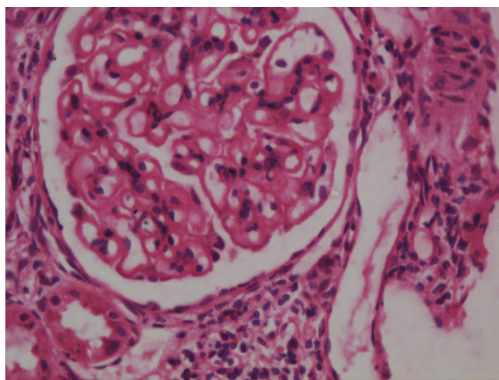
Figure 4: Giant mononuclear cells with pyknosis of nuclei indicat- ing active disease